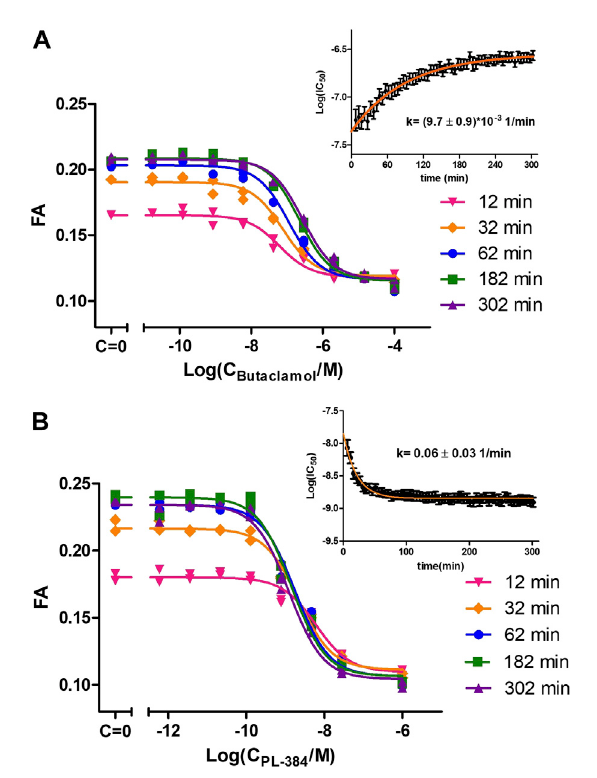
FIGURE 3 Displacement of CELT-419 by different concentrations of Butaclamol (A) and PL-384 (B) at different time points. The fi nal concentration of CELT-419 was 0.5 nM and 1 μ L BBV/well (C D3R = 0.7 nM) was used. The insert shows the Log(IC 50 ) ± SE change in time of corresponding displacement curves. Data from a single representative experiment performed in duplicate is shown. The Log(IC 50 ) change in time was fi tted with equation 3 and k given is the weighted average from 3 (A) or 4 (B) experiments with weighted